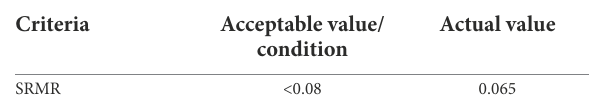
TABLE 9 Coefficients of determination (R 2 ).